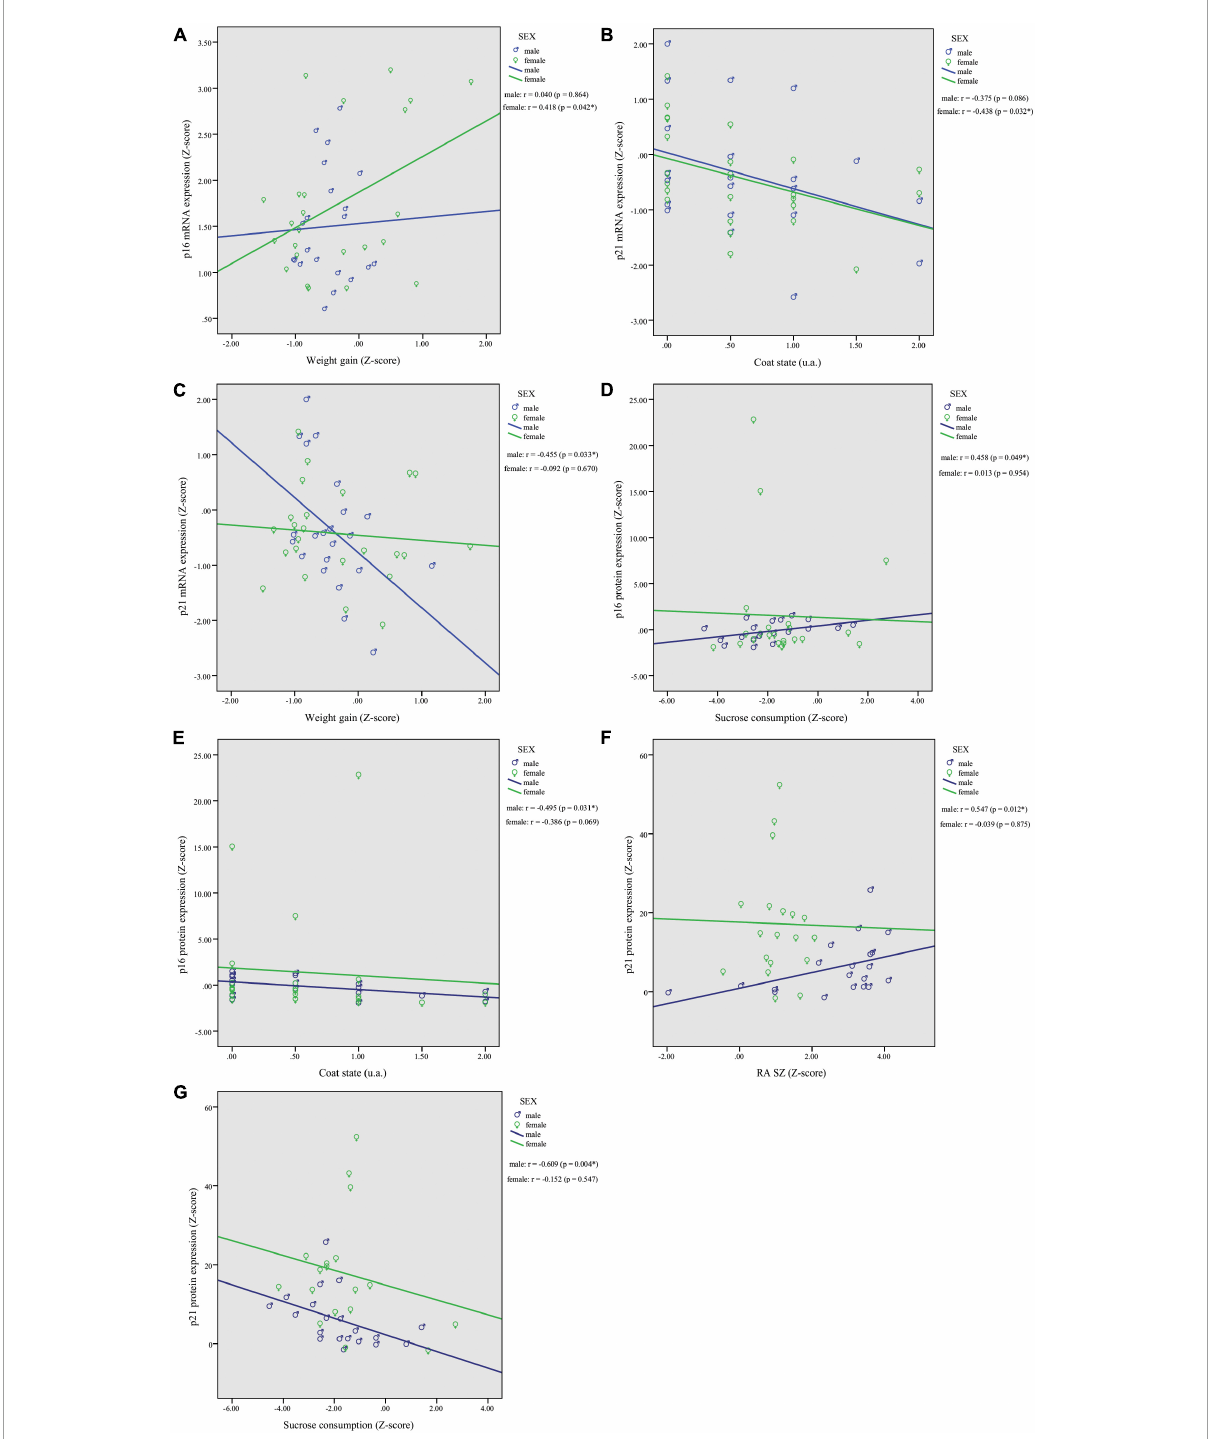
FIGURE3 Chronic restraint stress (CRS) leads to sexually dimorphic p16 INK4a and p21 Waf1 / Cip1 mRNA and protein expression changes in the PFC with associated behavioral responses. In females, correlations analysis revealed a significant association of p16 INK4a mRNA expression with weight gain (A) , and p21 Waf1 / Cip1 with worsened coat state (B) . In males, we found a significant correlation of p21 Waf1 / Cip1 mRNA expression and weight gain (C) . Higher protein levels of p16 INK4a showed a positive association with sucrose consumption (D) and worsened coat state (E) , and higher protein levels of p21 Waf1 / Cip1 were associated with greater (RA SZ) (F) and reduced sucrose consumption (G) . Data showed were obtained in both male and female. * p < 0.05, ** p <